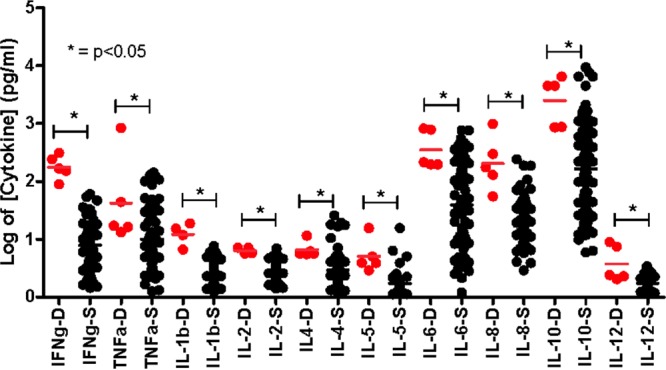
Cytokine levels in children with CM and SMA who died or who survived. Plot of log-transformed concentrations (in picograms per milliliter) of different cytokines (IFN-γ, TNF-α, IL-1β, IL-2, IL-4, IL-5, IL-6, IL-8, IL-10, and IL-12p70) in serum samples collected from five children who died (D, red dots) and those children who survived (S, black dots) after presenting with acute CM and SMA, showing medians and 10th and 90th percentiles.